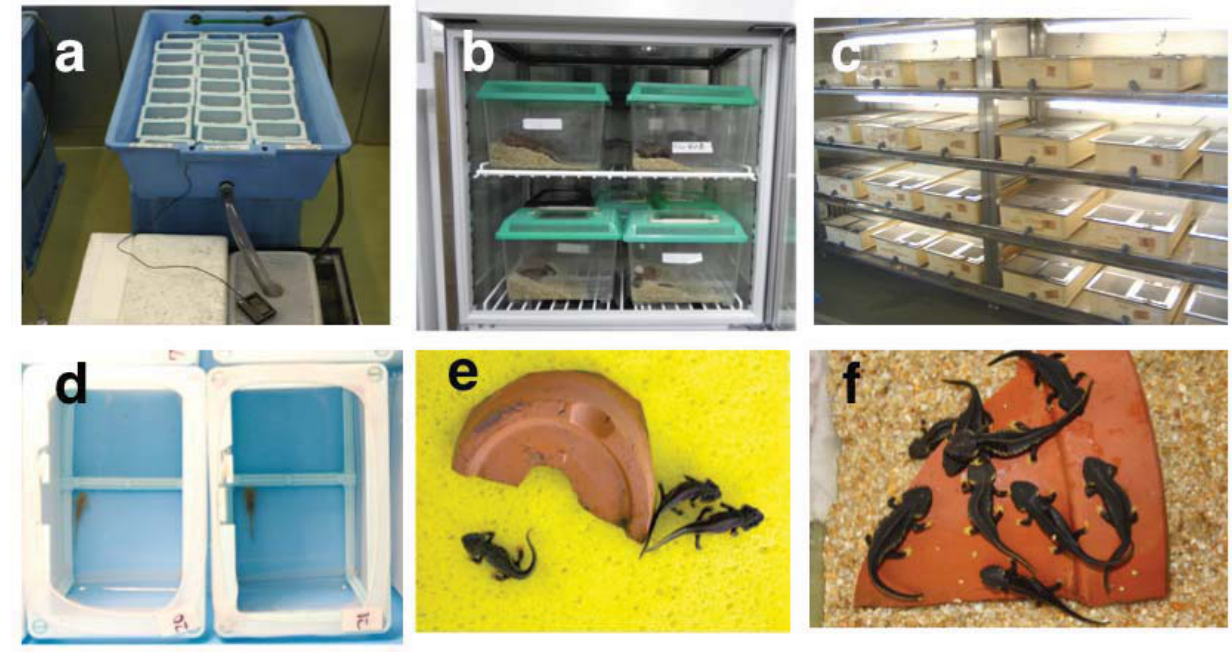
Figure 5. ( a , b ) Larvae were raised in nets maintained in a temperature-controlled water bath at 20 (cid:2) C and fed live Tubifex . ( b , e ) Metamorphosed newts were transferred to plastic containers containing wet sponges, kept in a temperature-controlled incubator at 22.5 (cid:2) C, and fed a diet of crickets. ( c , f ) One-year-old newts were housed in our frog room controlled at 25 (cid:2) C and fed a diet of